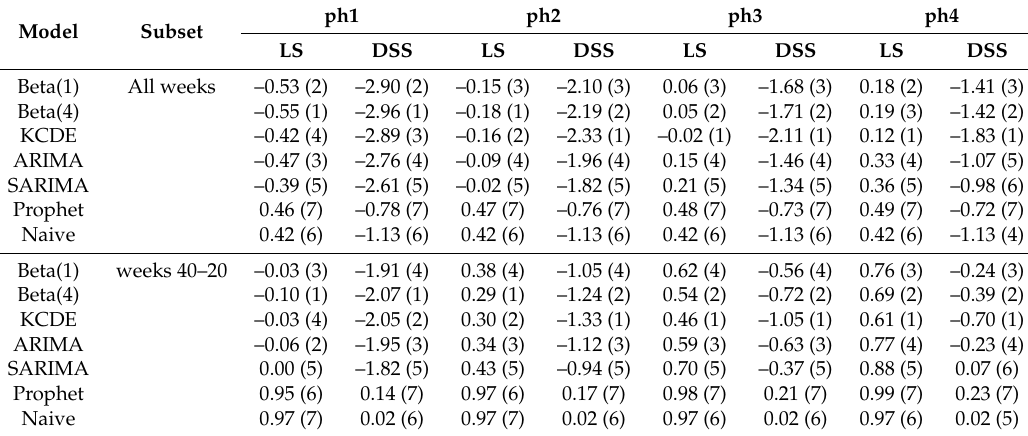
Table 2. Model performance in terms of log score (LS) and Dawid-Sebastiani score (DSS), averaged by prediction horizon (ph) of one-to-four weeks ahead. Ranks are shown in brackets. The “all weeks” group shows average scores over the whole test period, whereas the “weeks 40–20” group shows averages over the high incidence periods